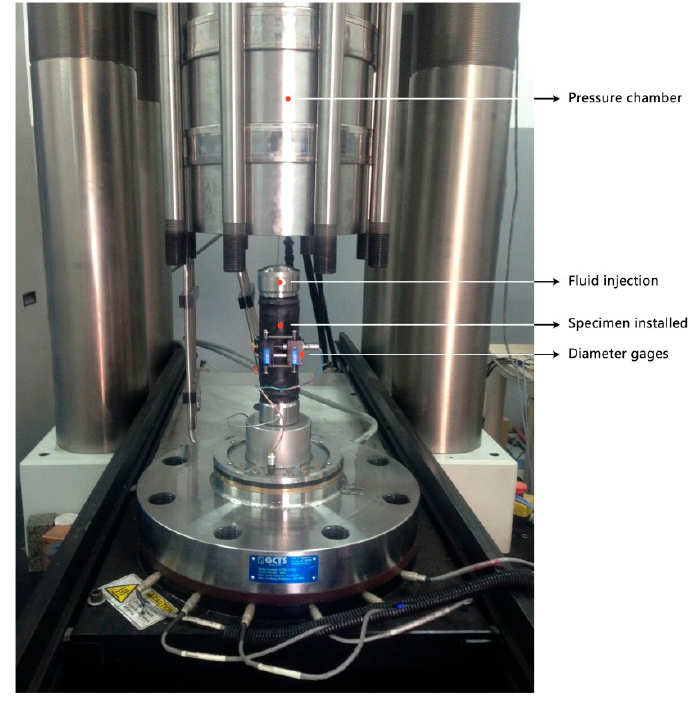
Figure 2. Photo of experimental devices installed.